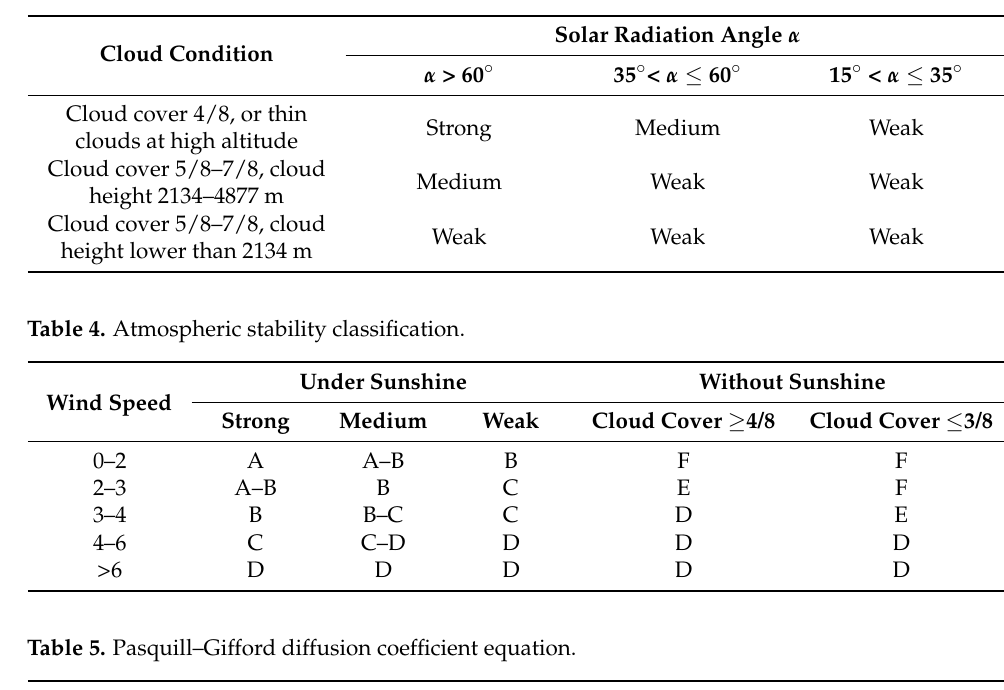
Table 3. Solar radiation intensity classification.